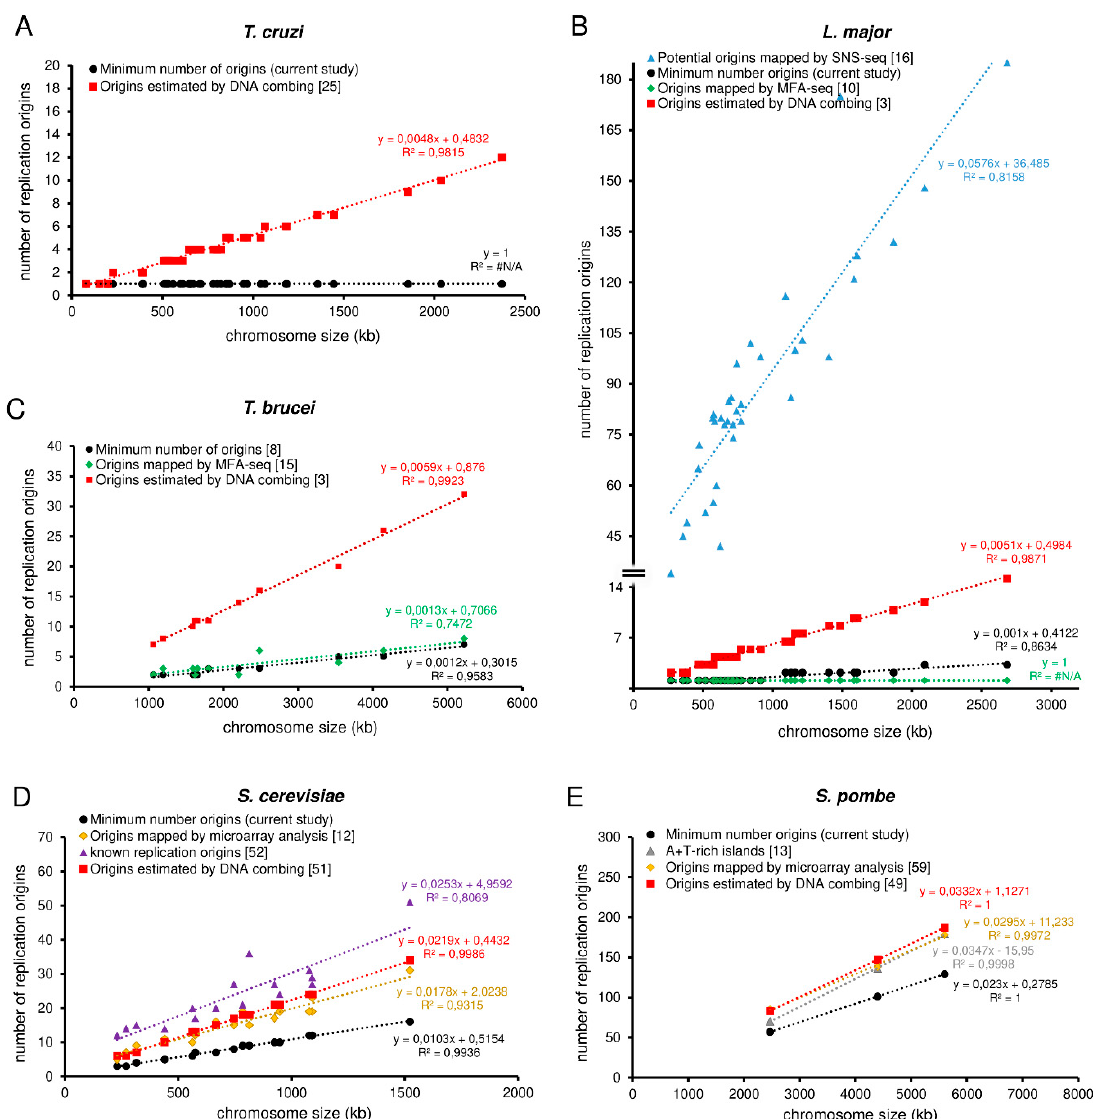
Figure 2. Comparative analysis among different approaches used to estimate replication origins in trypanosomatids ( T. cruzi , L. major , T. brucei ) and yeasts ( S. cerevisiae and S. pombe ) (a–e). Graphs showing positive correlations between chromosome length and the number of replication origins estimated by different approaches: minimum number of origins—MO (black), origins estimated by DNA combing (red), origins estimated by MFA-seq (green), potential origins mapped by SNS-seq (blue), origins estimated by microarray (yellow), known origins (purple), and A + T rich islands (gray). ( A ) T. cruzi , ( B ) L. major , ( C ) T. brucei , ( D ) S. cerevisiae , and ( E ) S. pombe . The trend lines for all approaches, as well as the equations, are shown. Studies are referenced in each graph.